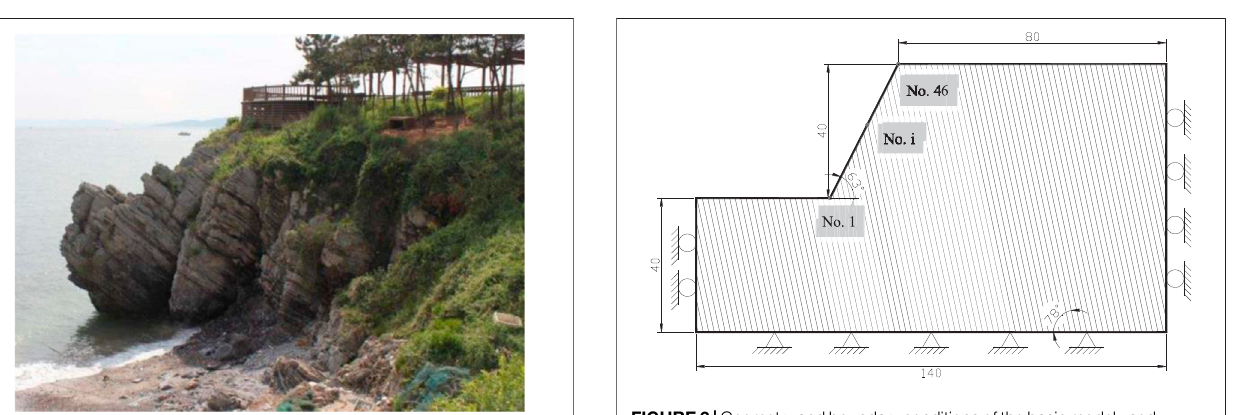
FIGURE 1 | An anti-dip bedding rock slope facing Bohai Sea in China modi fi ed from Zhao et al. (2020).